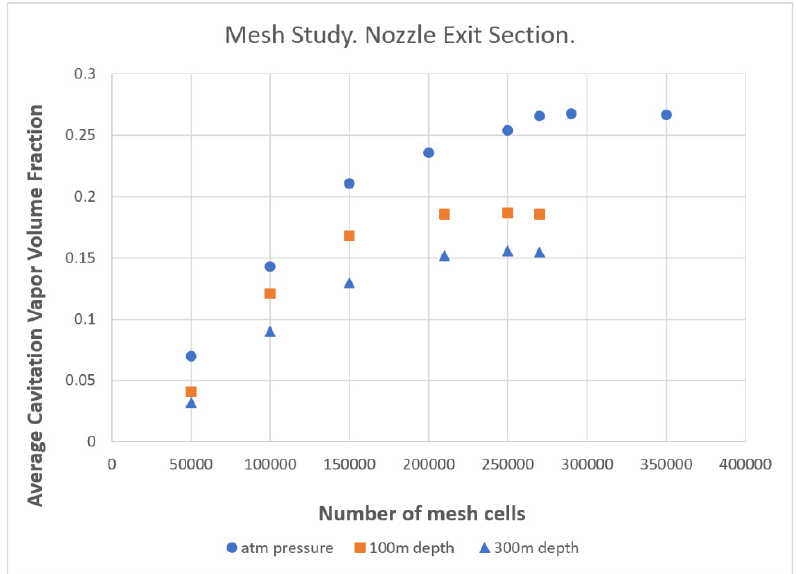
Figure 3. Mesh structure near nozzle exit. Size of elements: 0.1 mm, 0.2 mm, 0.5 mm.